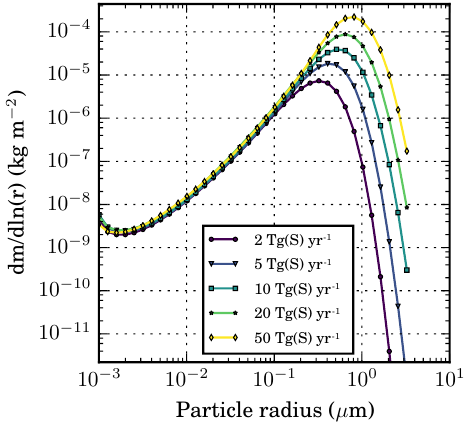
Figure 7. (a) Forcing efficiency (i.e. ratio of global mean instanta- neous radiative forcing by the global sulfur injection rate) for the x _TGS simulations with different injection rates. The SW compo- nent is shown in dark blue, the LW component in light blue, and the net flux in orange. Panels (b) to (d) show the decomposition of the forcing efficiency as described in the text (see Eq. 1). The solid lines show the results from the described LMDZ-S3A simulations, while the crosses show results from a previous study by Niemeier and Timmreck (2015).